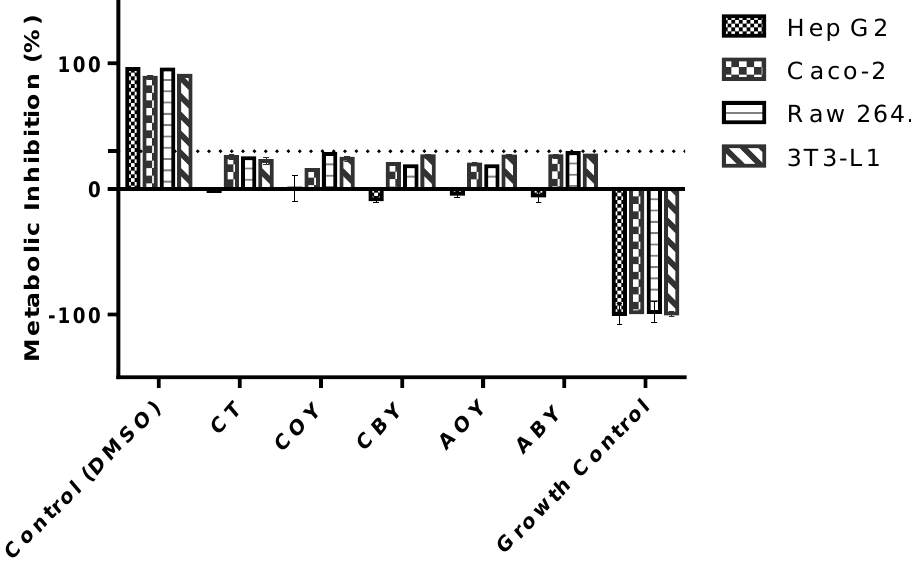
Figure 2. Effect of yogurt-digested samples on the metabolic activity of the target cell lines. The dotted line represents the 30% cytotoxicity limit as defined by ISO 10993-5:2009. CT — control yogurt, COY — coconut oil yogurt; CBY — coconut bigel yogurt; AOY — avocado oil yogurt; ABY — avocado bigel yogurt.